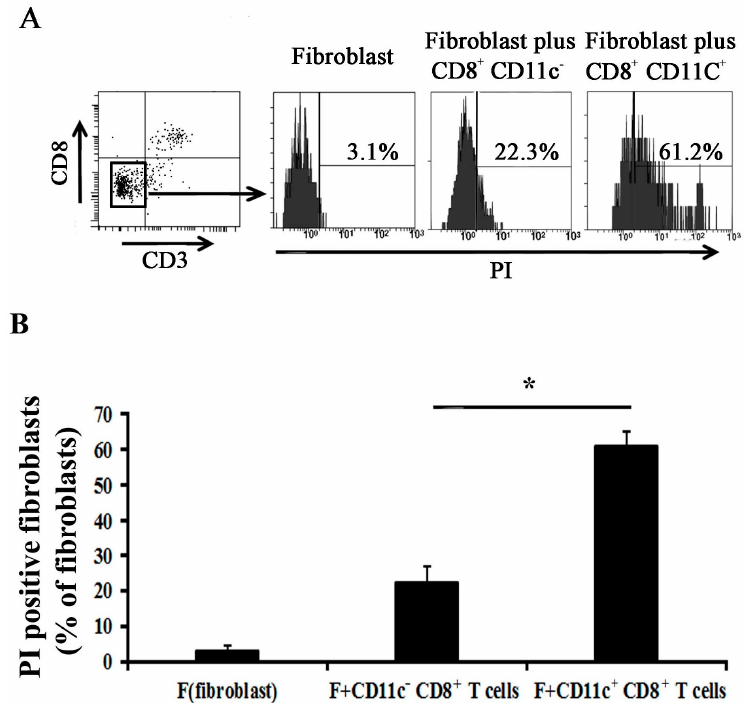
Figure 6. CD11c + CD8 + T cells isolated from obstructed kidney can induce fibroblast death in vitro. ( A ) Fibroblasts were co-cultured with CD11c − CD8 + T cells or CD11c + CD8 + T cells for 24 h; the cells were subsequently harvested to analyze the mortality of CD8 − CD3 − cells (fibroblast) through PI (Propidium Iodide) staining combined with flow cytometry; the CD8 + T cell-free set-up served as control; ( B ) Quantitative analysis of the percentage of PI staining-positive fibroblasts. (* p < 0.05 vs. fibroblasts plus CD11c − CD8 + T cells; n = 5/group).